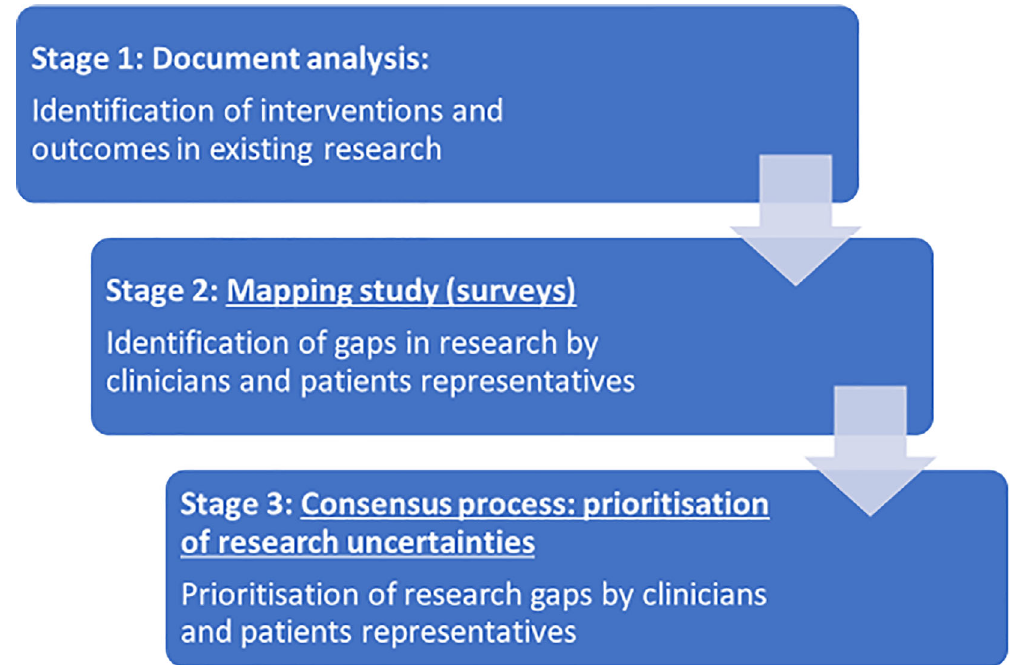
Figure 1. Flow chart of the method